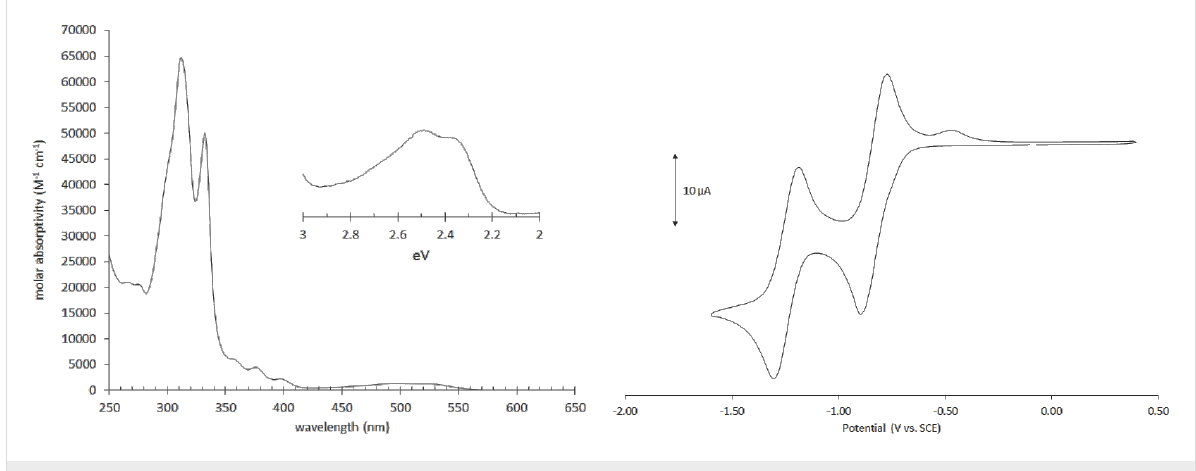
Figure 2: UV–vis spectrum (left) and cyclic voltammogram (right) of dione 8c .